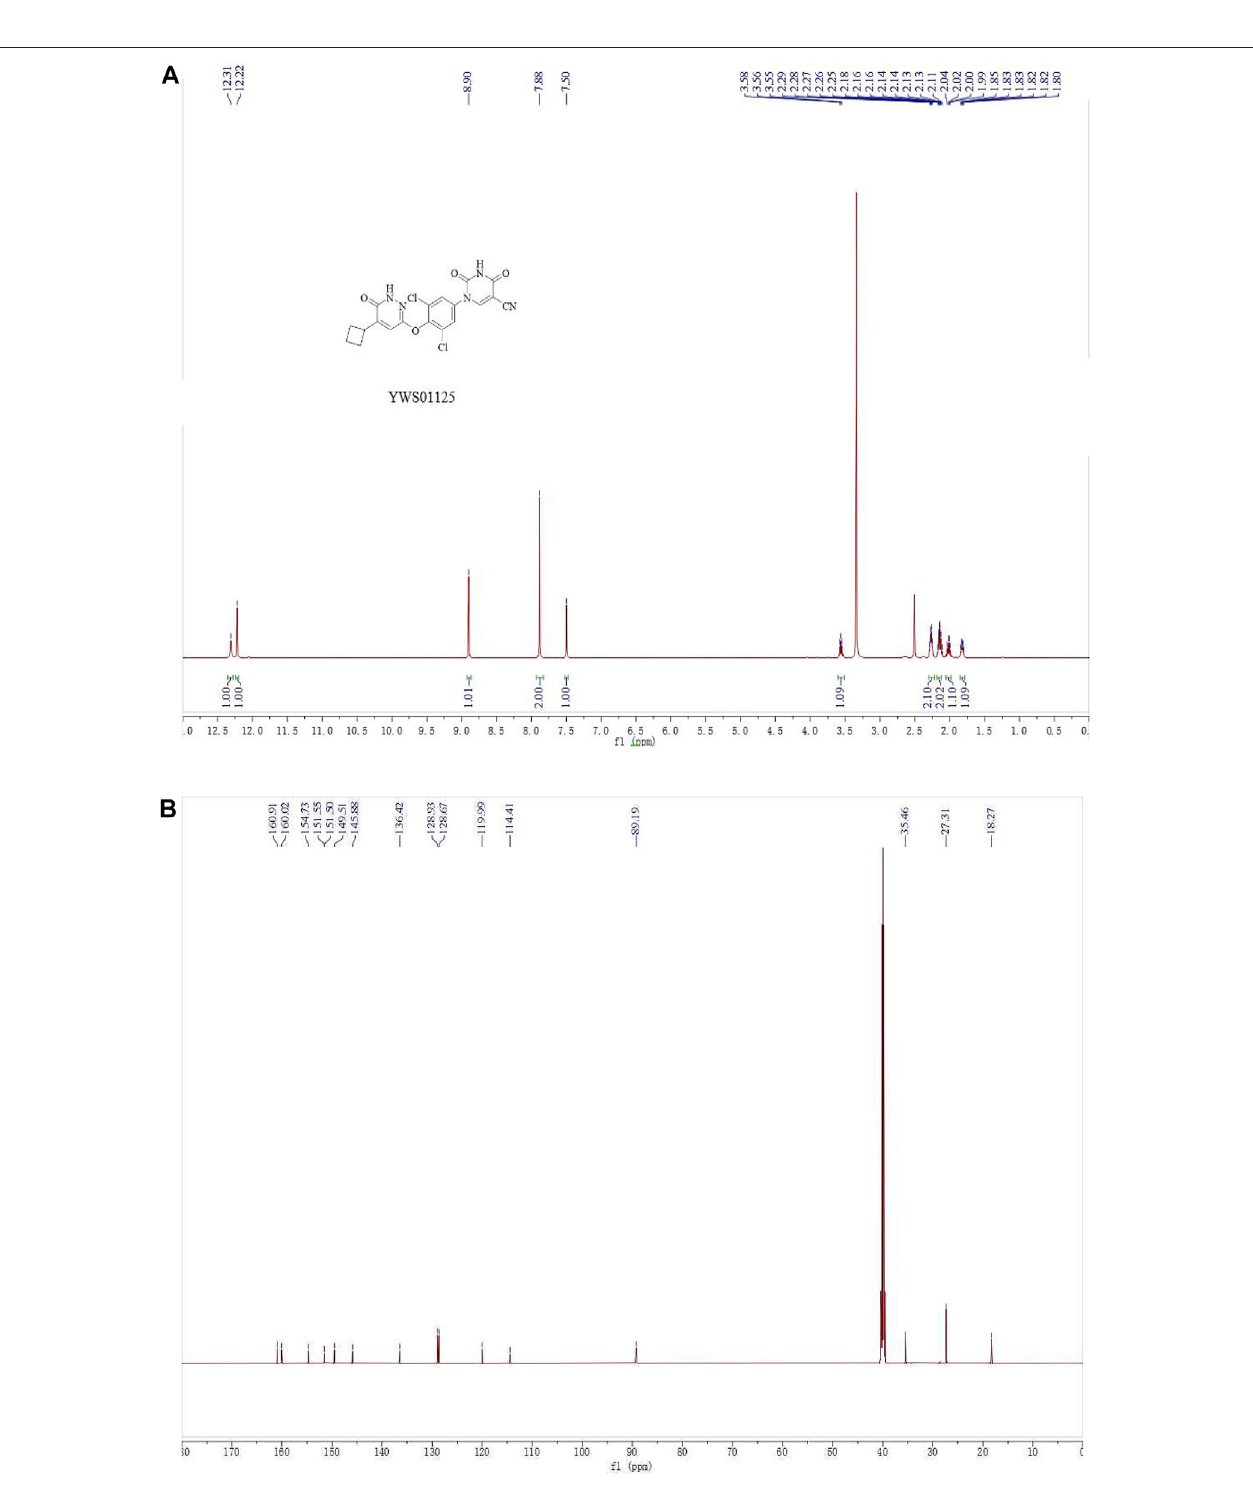
FIGURE 2 | (A) 1 H NMR spectra of YWS01125 . (B) 13 C NMR spectra of YWS01125.